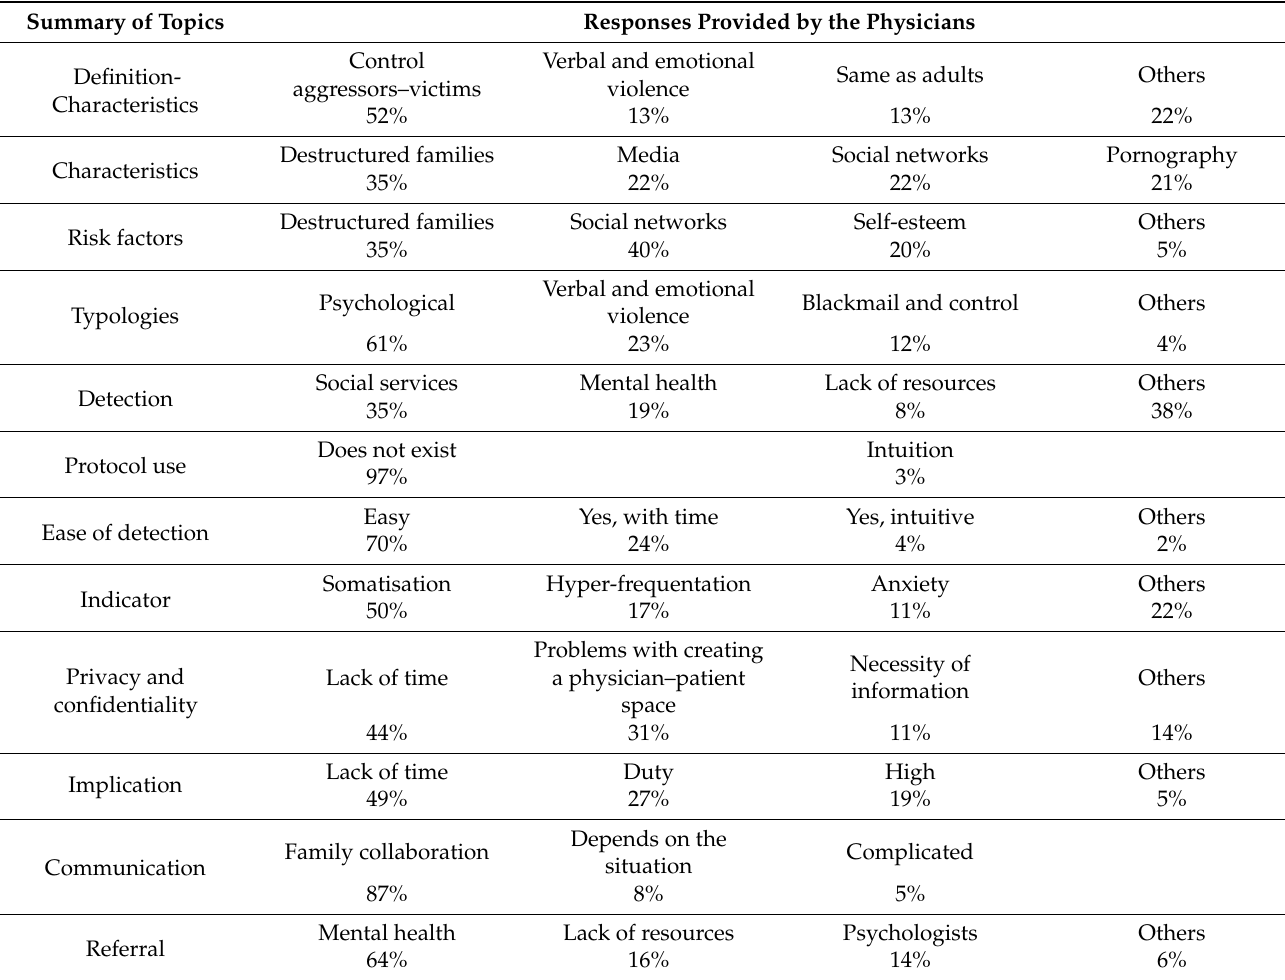
Table 2. Summary of the percentage of the type of responses provided by the